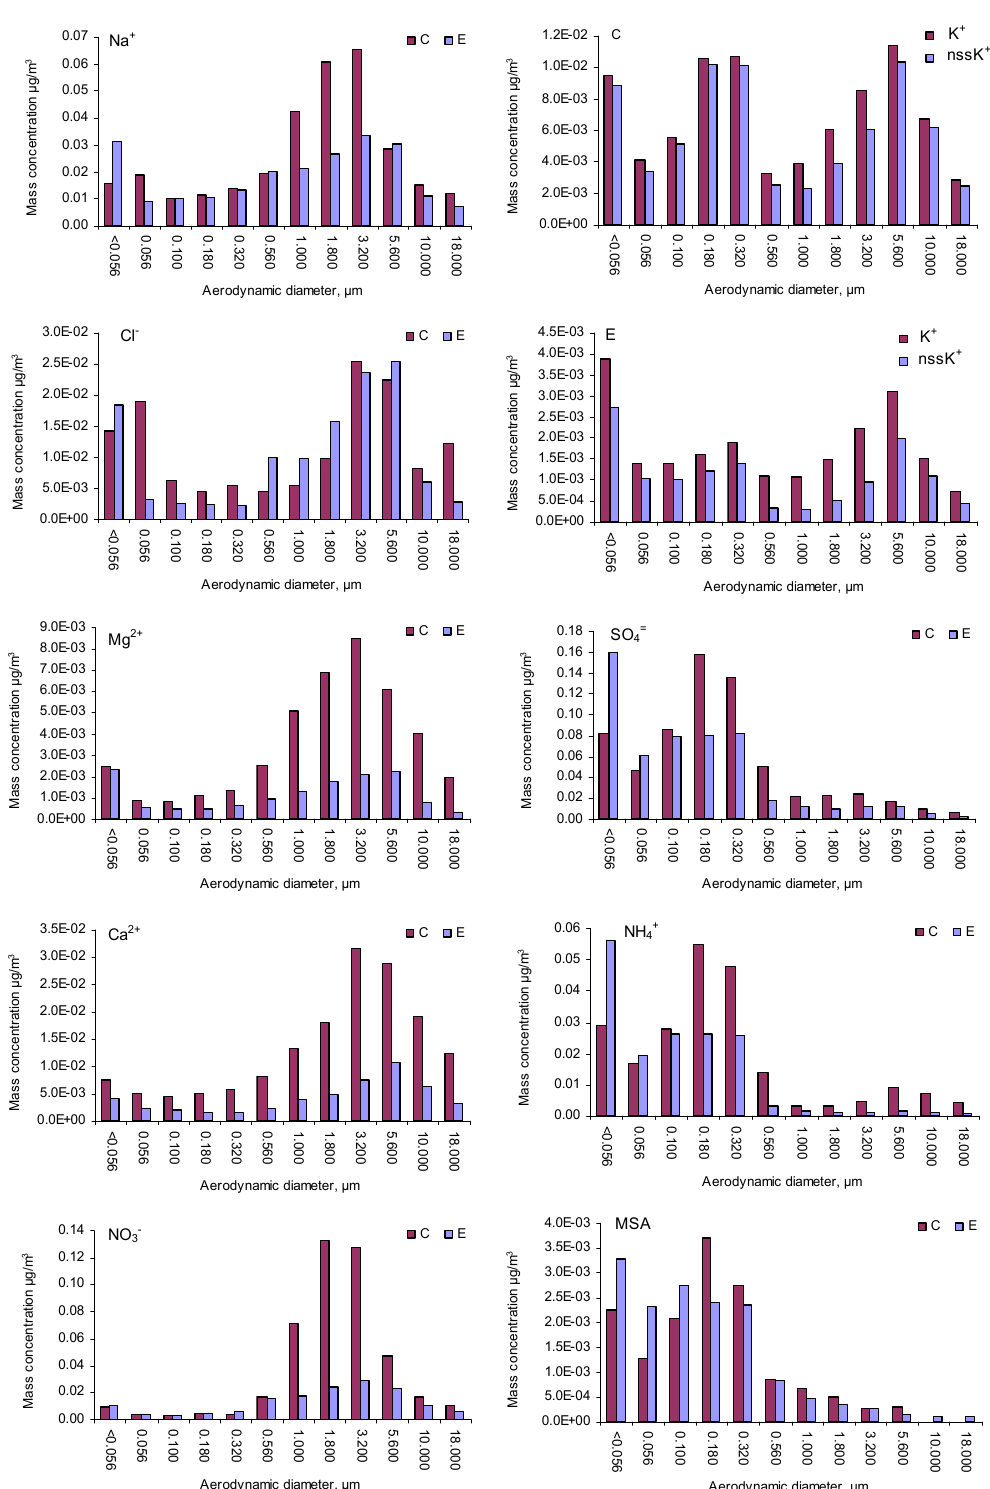
Fig. 11. Size-resolved concentrations of major water-soluble ionic species during sampling periods C and